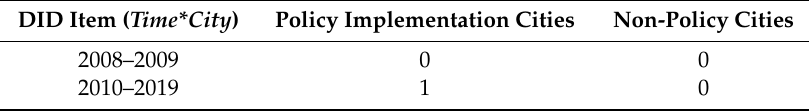
Table 4. Values of the explanatory variable Time*City